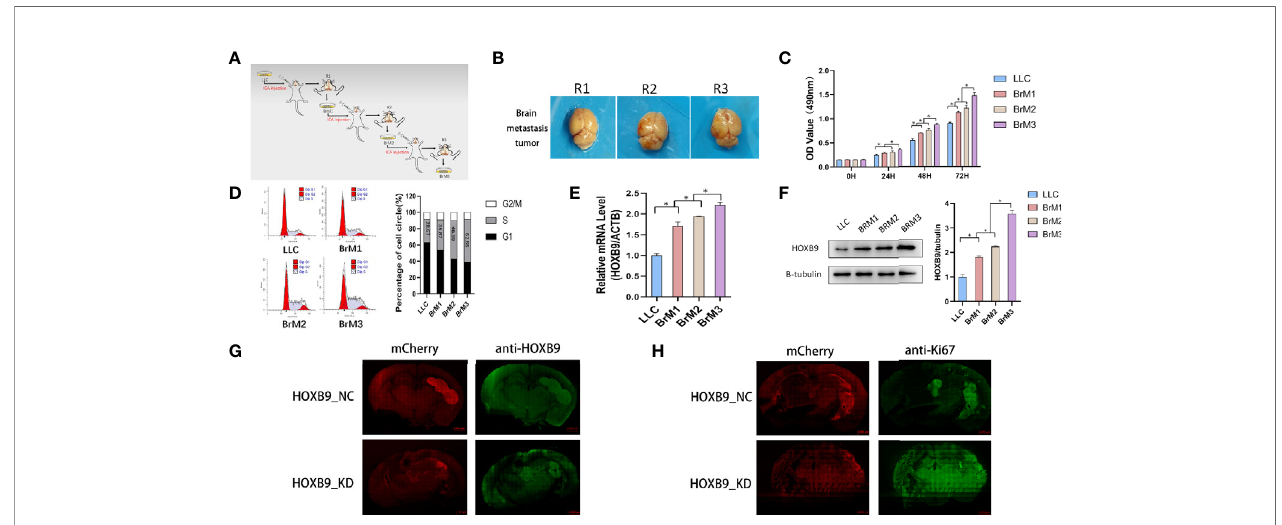
FIGURE 8 | Downregulation of HOXB9 decreased the intracranial tumorigenicity of the brain metastatic lung tumors. (A) The schematic diagram of establishing the mouse model of brain metastasis of lung tumor. (B) The brain metastatic tumors in the three rounds of modeling via ICA injection. R1: the fi rst round of modeling via ICA injection; R2: the second round of modeling; R3: the third round of modeling. (C) Cell viability analysis of the brain metastatic tumor cells, derived from three rounds of mouse models and the parental LLC cells, BrM1: brain metastatic tumor 1, deriving from the mouse model in fi rst round of modeling, R1; BrM2: brain metastatic tumor 2, deriving from R2; BrM3: brain metastatic tumor 3, from R3. * p < 0.05. (D) Flow cytometry analysis for the cell cycle progression of BrMs and parental LLC cells. (E) Determination of HOXB9 expression in the level of mRNA via real-time PCR, * p < 0.05. (F) Western blot analysis for the expression of HOXB9, * p < 0.05. (G) The downregulation of HOXB9 in LLC-BrM (also indicated as BrM3) decreased the size of intracranial colonization, the red fl uorescence mCherry indicated the location of intracranial metastases, and the green fl uorescent anti-HOXB9 denoted the expression of HOXB9, scale bar 1000 m m. (H) Downregulation of HOXB9 decreased the expression of Ki67 in LLC-BrM, the green fl uorescence indicated the expression of Ki67. Scale bar indicating 1000 m